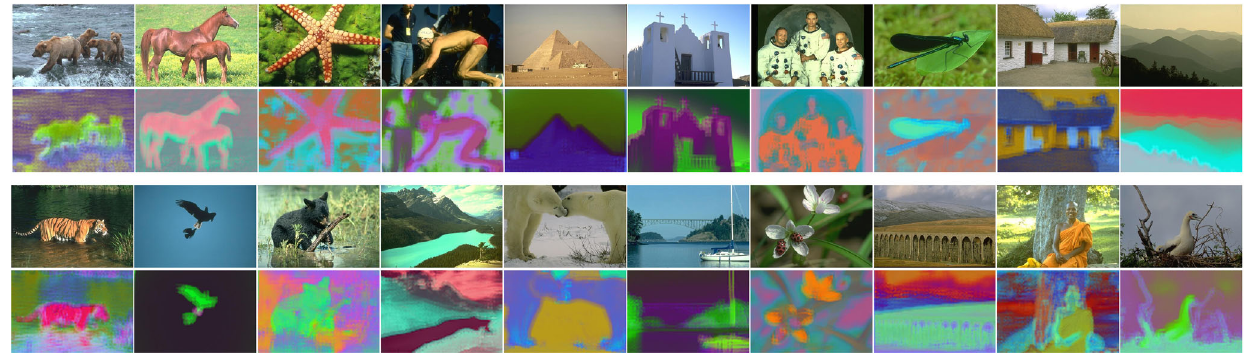
Fig. 1 Given a natural input image, our technique learns a high-dimensional embedding space, where Euclidean distances between embedded image patches reflect their similarity (visualized in pseudo-RGB